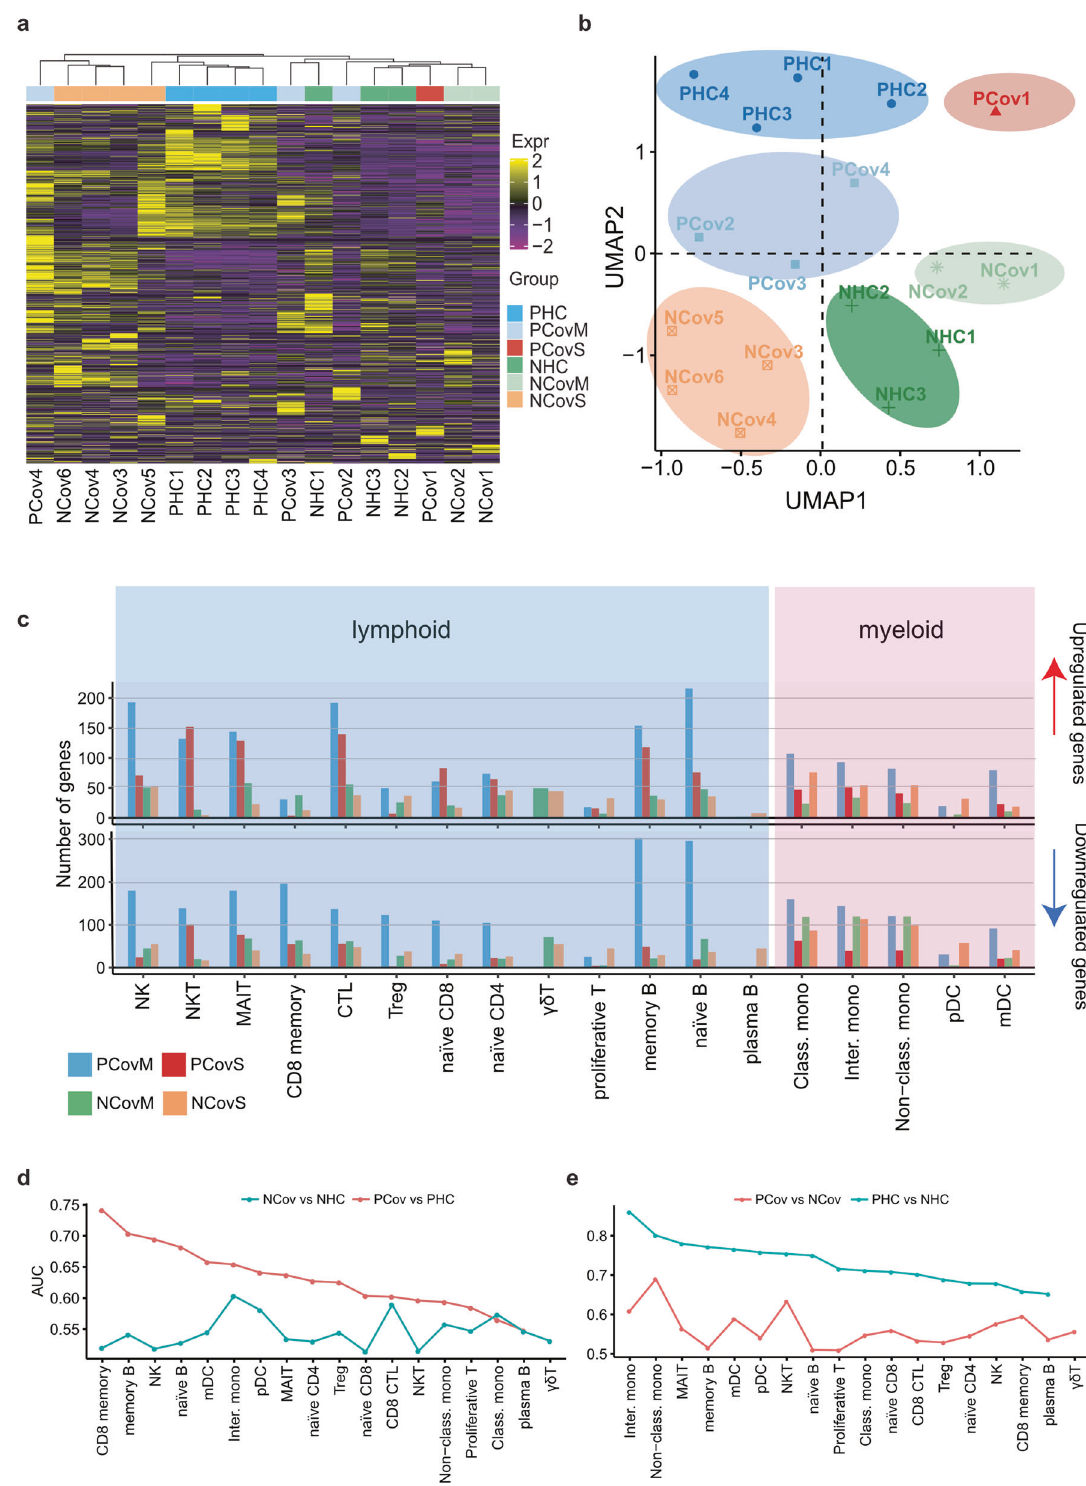
Fig. 2 Pregnancy-associated immunity impact on anti-SARS-CoV-2 responses. a Heatmap of differentially expressed genes identi fi ed from pseudo-bulk gene analysis. The color scale indicates Z score-transformed expression level. b The UMAP projection of 17 donors based on the pseudo-bulk gene expression matrix presented in a . Samples were colored and shaded according to their assigned groups. Blue, pregnant patients who developed mild symptoms (PCovM); red, pregnant patient who developed severe symptoms (PCovS); green, non-pregnant patients who developed mild symptoms (NCovM); orange, non-pregnant patients who developed severe symptoms or had prolonged viral shedding (NCovS). c Upregulated or downregulated differentially expressed genes (DEGs) in each cell type of recovered COVID-19 patients compared to their corresponding healthy controls (PCovM and PCovS compared to PHC; NCovM and NCovS compared to NHC). Prioritizing the most affected cell types in response to COVID-19 ( d ) or pregnancy ( e ) by ranking the AUC scores derived from Augur algorithm 43